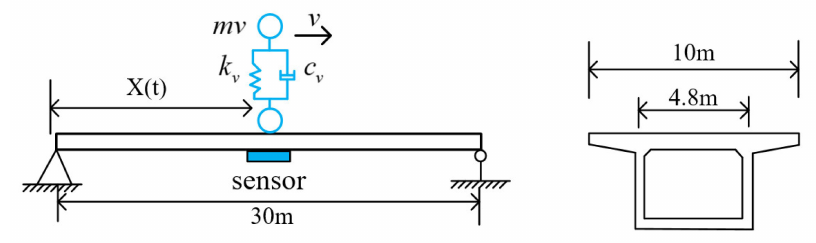
Figure 5. Vehicle-bridge system with single degree of freedom.